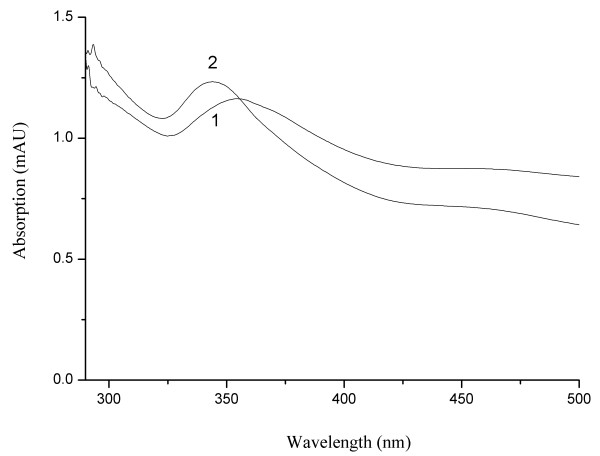
The UV–vis absorption of C60dispersions. (1). Directly dissolved in water, (2). Prepared by solvent replacement.